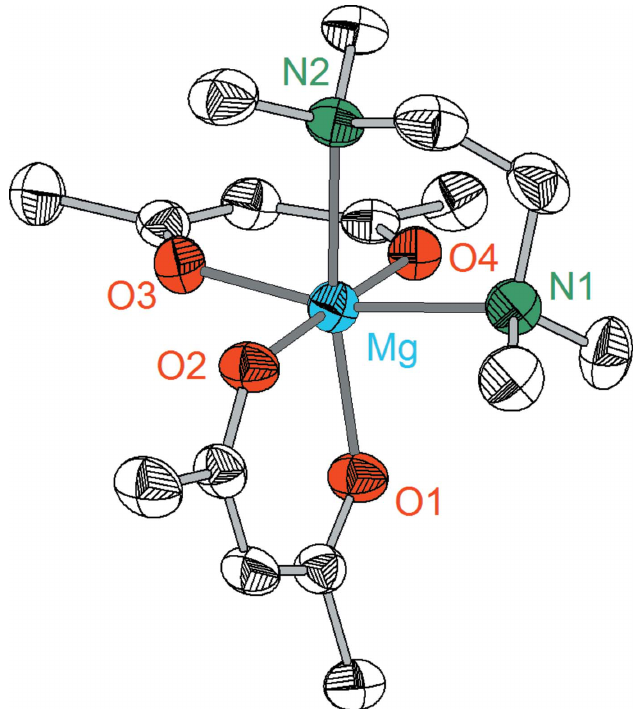
Figure 1 The molecular structure of [Mg(acac) 2 TMEDA in the crystal. Displace- ment ellipsoids are drawn at the 50% probability level; H atoms are omitted for